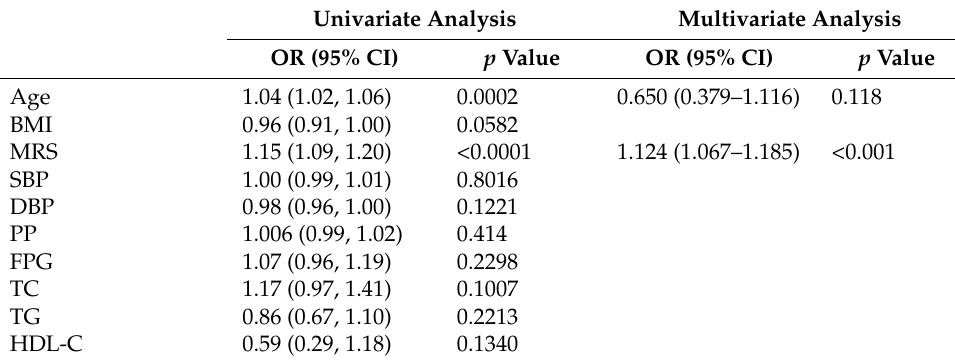
Table 3. Univariate and multivariate analysis of LVSI in the training cohort. Univariate